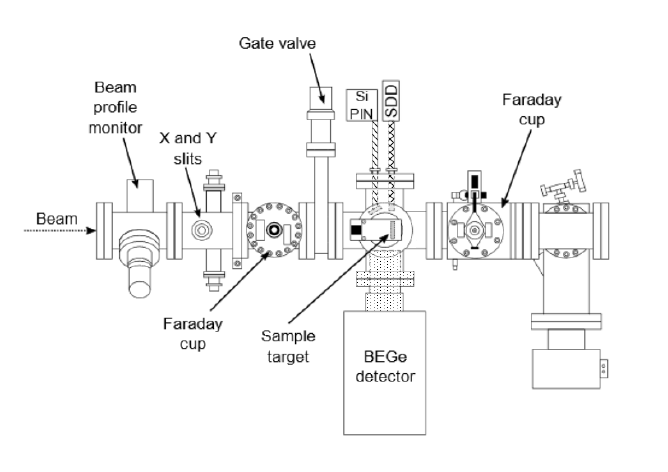
Fig. 1. Scheme of the IBA chamber in the CENTA